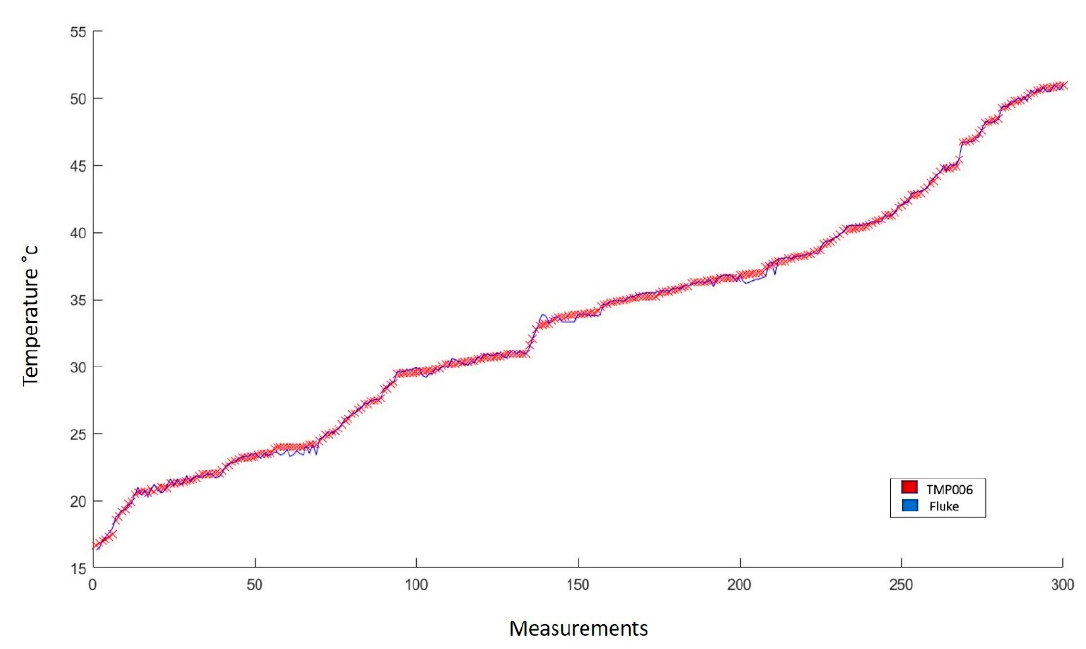
Figure 9. Comparison of the behavior of measurements made with the FLUKE infrared thermometer and with the TMP006 sensor. In total, 387 measurements were made in the range from 16 to 50 °C. Using the SHT75 temperature and humidity sensor and Equation (5), the temperature was calculated, SOt being the measurement obtained from the temperature sensor. The linear humidity (without temperature compensation) and the compensated humidity values were calculated with Equations (6) and (7), where SOrh is the measurement provided by the humidity sensor and T is the calculated temperature [49,71]. Figure 6 shows the scheme obtained from the VHDL code.